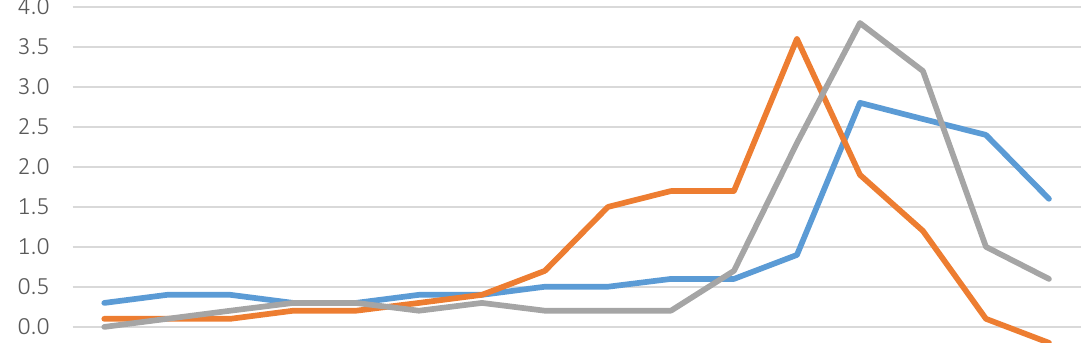
Figure 8. Bank losses as a percentage of total bank assets in Scandinavia